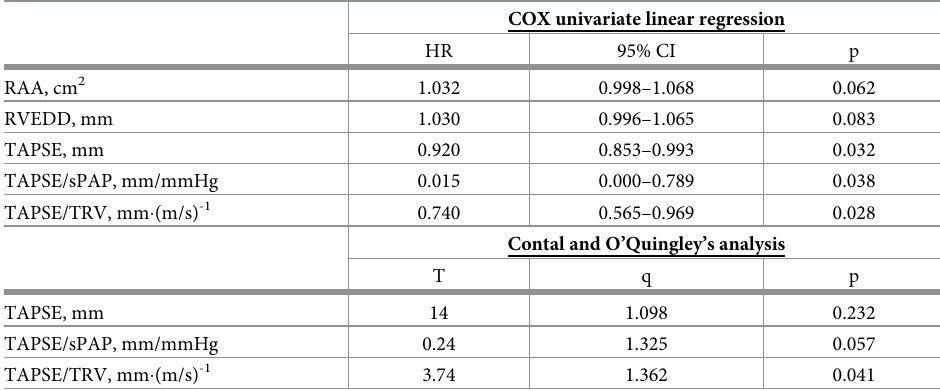
Table 3. Univariate regression analysis.